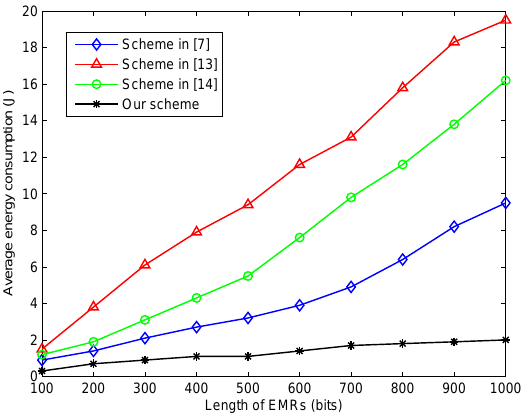
Figure 4. The average energy consumption for different lengths of